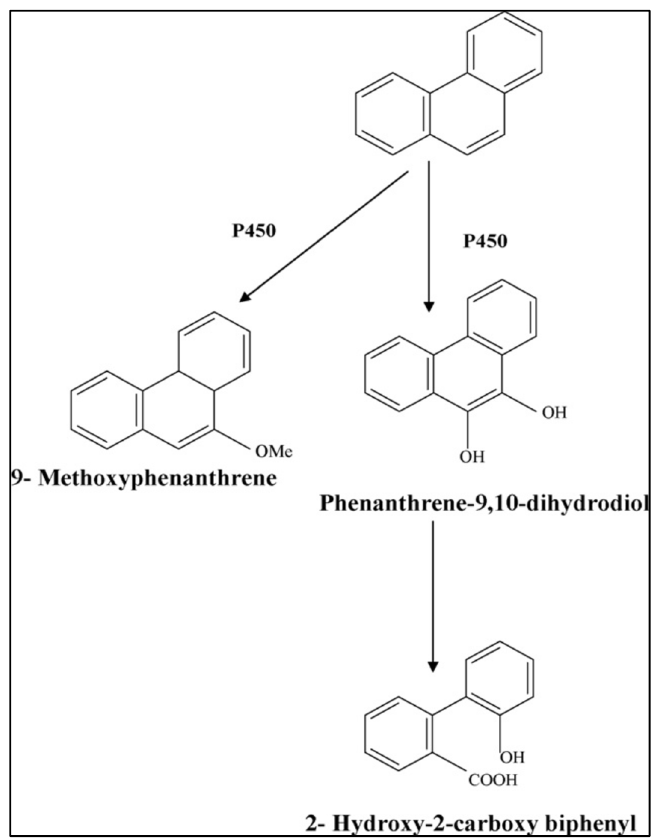
Figure 4. Fungal degradation pathway of phenanthrene by Irpex lacteus fungus [164,165].